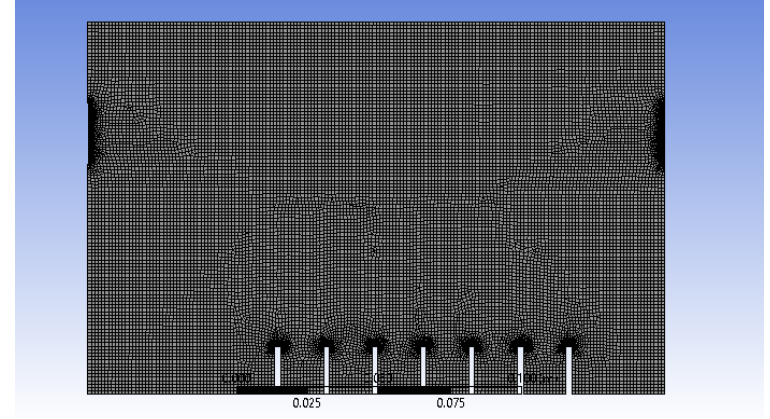
Figure 3. Meshing of 2D model of atomisation chamber.